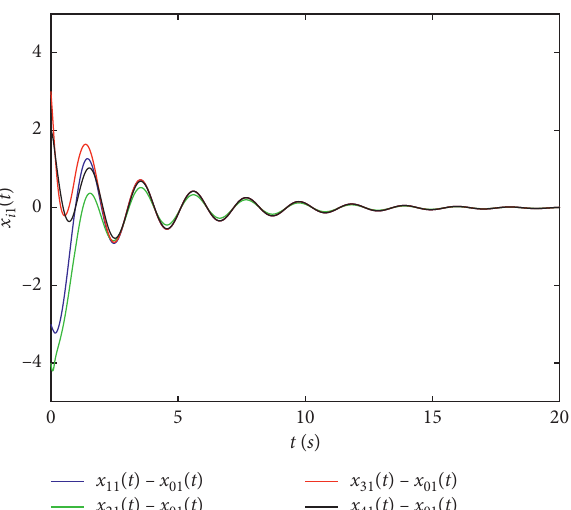
Figure 3: The 1st state error trajectory of each agent under protocol